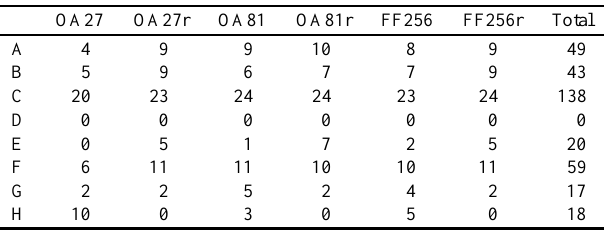
Table 4 Parameter contribution scores, sorted by dataset